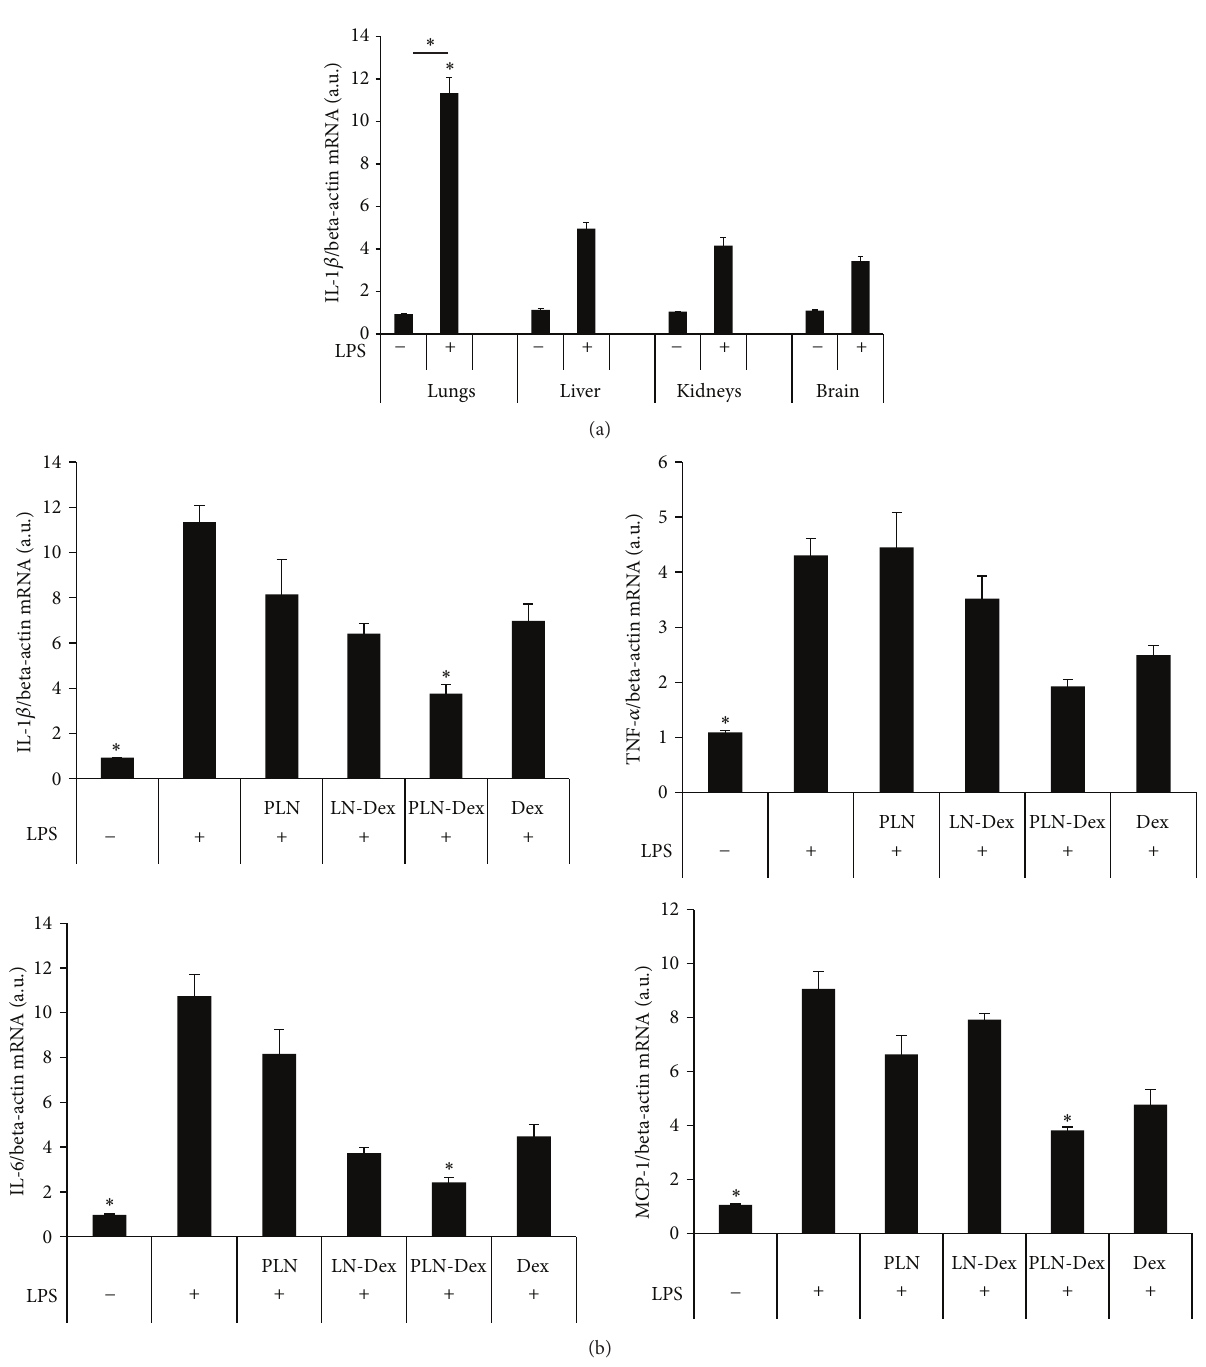
Figure 5: (a) Systemic increase of IL-1 𝛽 mRNA levels in homogenates of lungs, liver, kidneys, and brain of LPS-treated mice, as determined by RT-PCR and normalized to beta-actin mRNA level. (b) The effect of administration of free dexamethasone (Dex) or encapsulated in nontargeted (LN-Dex) or P-selectin targeted (PLN-Dex) lipid nanoemulsions in LPS-injected mice on mRNA levels of IL-1 𝛽 , TNF- 𝛼 , IL-6, and MCP-1 in lungs homogenates as determined by quantitative RT-PCR and normalized to beta-actin mRNA level. Empty PLN were used as control nanoemulsions. Results are expressed as fold induction over the PBS-treated mice, considered as 1. The data are expressed as mean ± SD; 𝑛 = 3–6 mice per group; ∗ 𝑝 < 0.05 statistically significant versus LPS